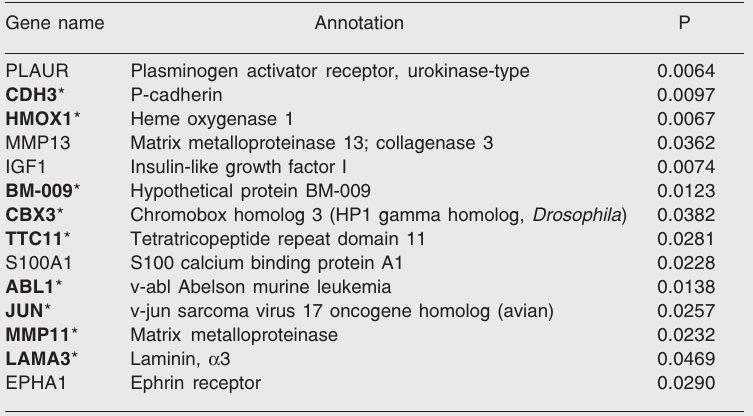
Table 6. Fourteen genes differentially expressed in breast cancer and in normal tissue as determined by a meta-analysis.